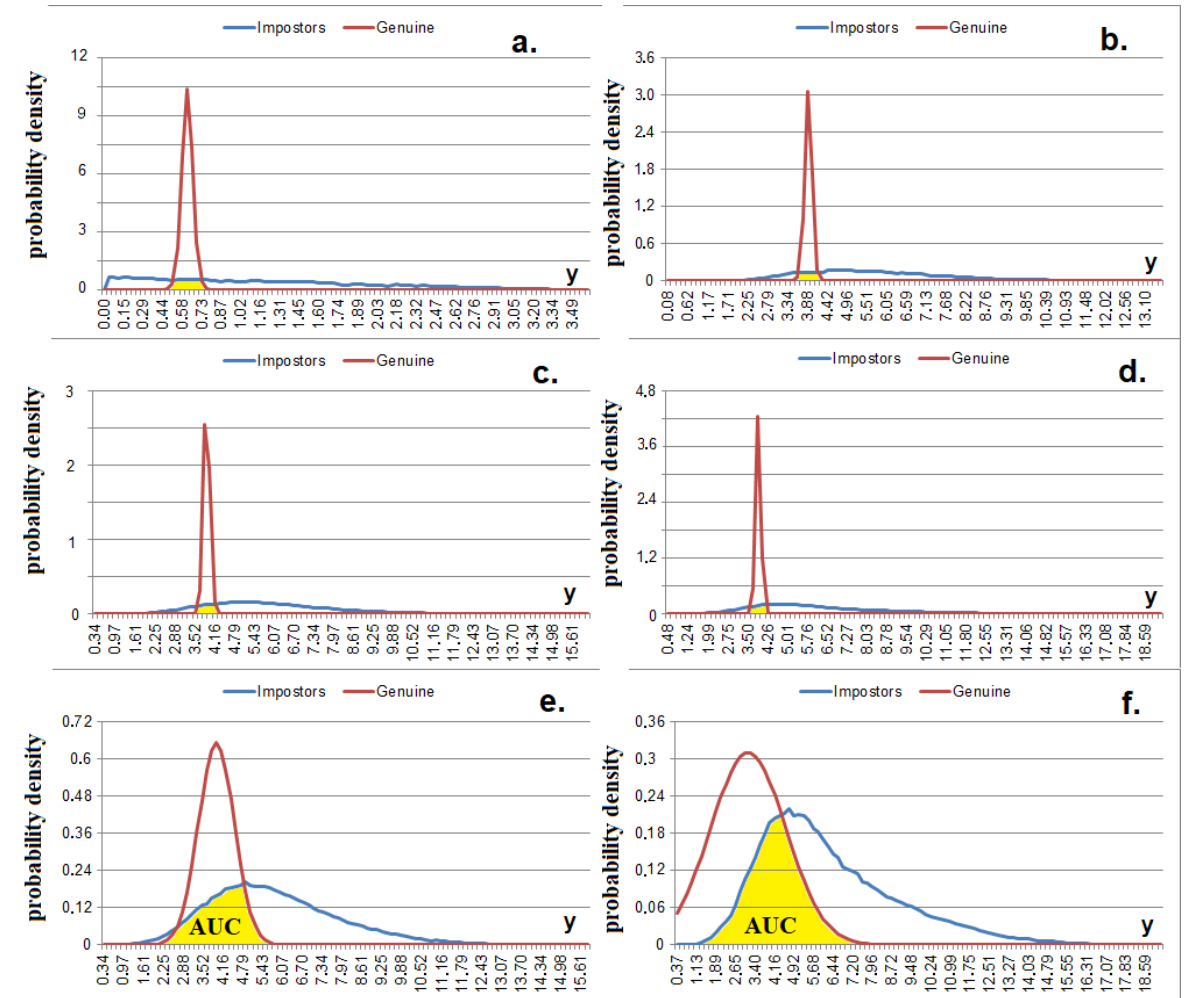
Figure 4. Probability densities of Measure (5) values (without square root) at p = 1, I≈ 1.75 bits. ( a ) for